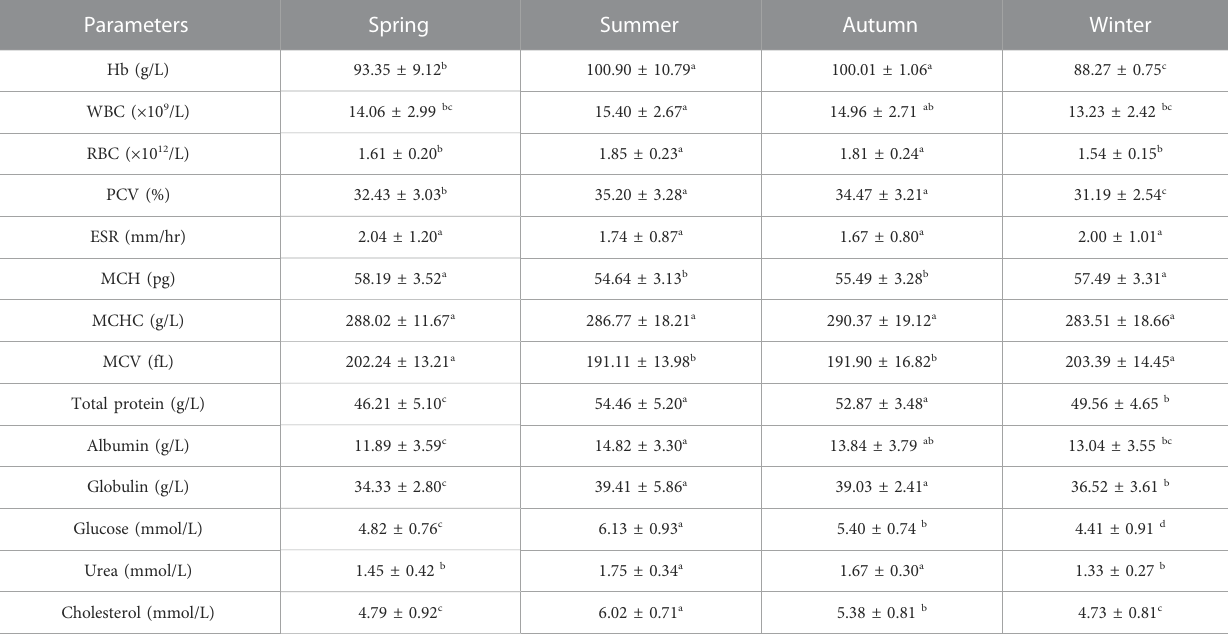
TABLE 5 Seasonal variations in hematological and serum biochemical parameters of male S. esocinus from River Jhelum a . Parameters